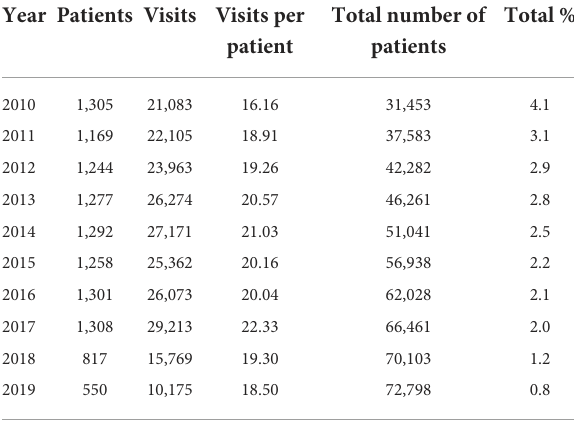
TABLE 7 CMPP visits among patients receiving a prescription for